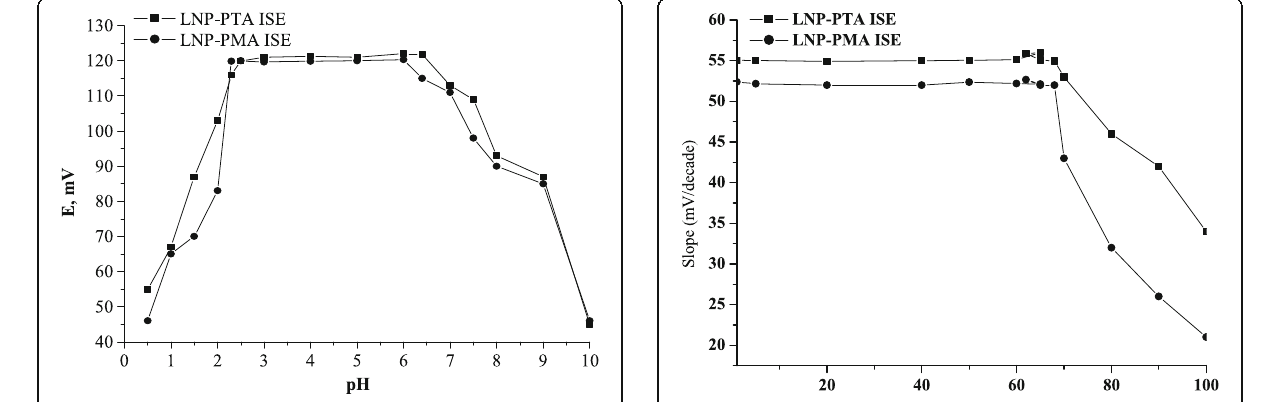
Fig. 6 Effect of pH on potential of 5.0 × 10 − 4 mmol l − 1 LNP for LNP- PTA and LNP-PMA ISEs